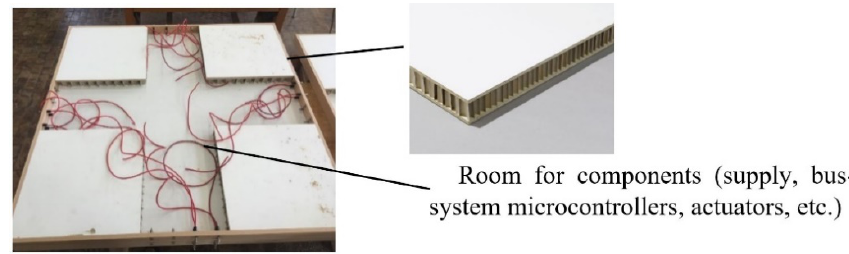
Fig. 8. Prototype with cross section (bottom